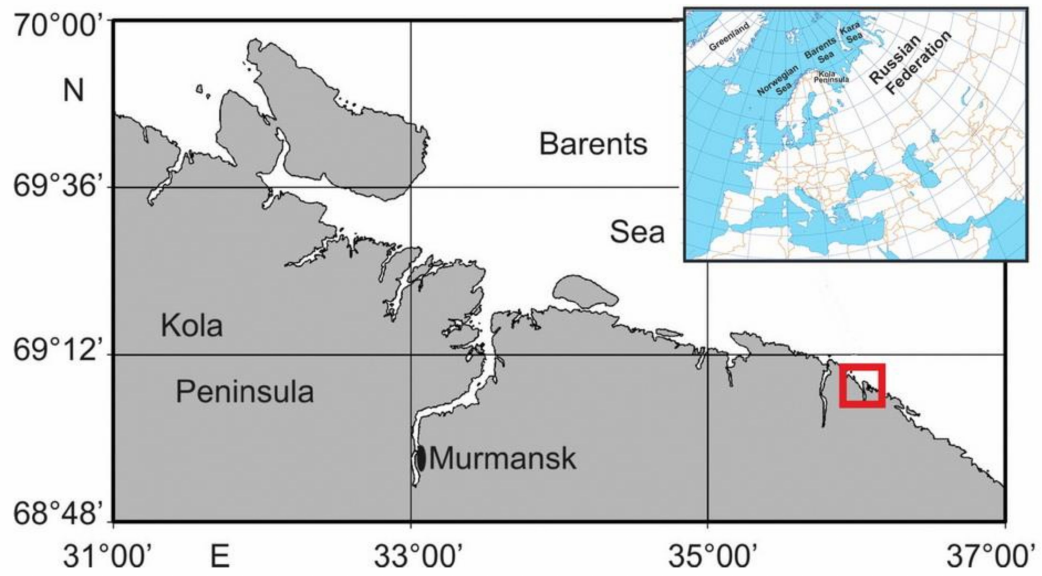
Figure 1. Location of the study area (Dalnezelenetskaya Bay, 69 ◦ 07 (cid:48) N, 36 ◦ 05 (cid:48) E). Each crab was examined for the sex (according to the form of the abdominal flaps), carapace length (CL, the greatest straight-line distance across the carapace from the poste- rior margin of the right eye orbit to the medio-posterior margin of the carapace), and shell condition according to Donaldson and Byersdorfer